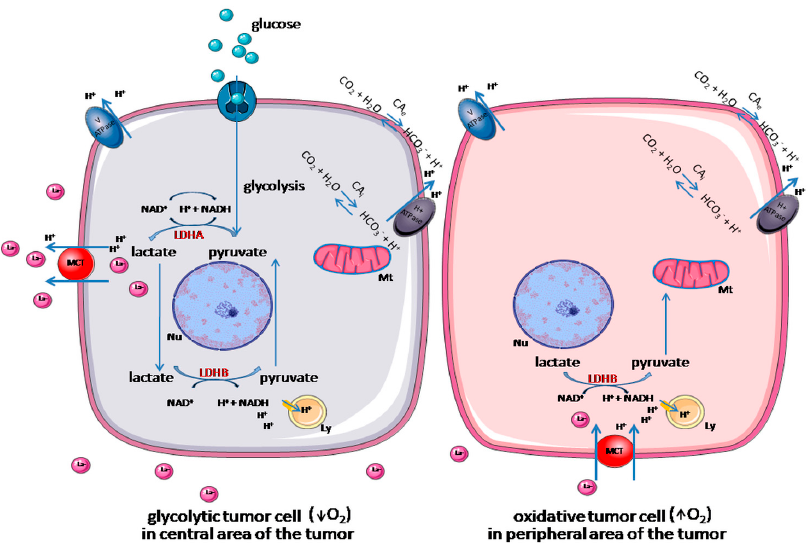
Figure 2. Metabolic symbiosis of tumor cells. Tumor cells, which are presented in the hypoxic area are addicted to anaerobic glycolysis. They oxidize glucose to pyruvate and lactate, which is then exported from the cell, or oxidized back into pyruvate. Then, lactate is taken up by oxidative tumor cells and oxidized to pyruvate, which fuels oxidative phosphorylation [17]. Intracellular pH homeostasis is maintained by several transporters and pumps facilitating an H + e ffl ux. Monocarboxylate transporter (MCT) facilitates the export of lactate and H + , while H + ATPase and V ATPase extrude H + from the cytosol to the extracellular matrix [20]. Ly = lysosome, Mt = mitochondrion, Nu = nucleus, LDHA = lactate dehydrogenase A, LDHB = lactate dehydrogenase B, MCT = monocarboxylate transporter, CA i = intracellular carbonic anhydrase, CA e = extracellular carbonic anhydrase. The main figure conception adapted from Brisson et al. (2016), and from Damaghi et al. (2013). Graphical elements adapted from Servier Medical